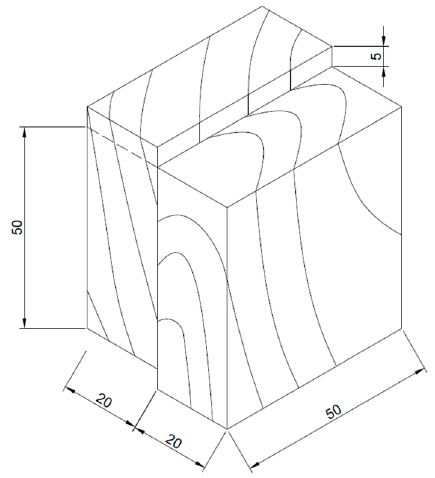
Figure 2. Diagram of wood glulam test specimen for shear strength test.